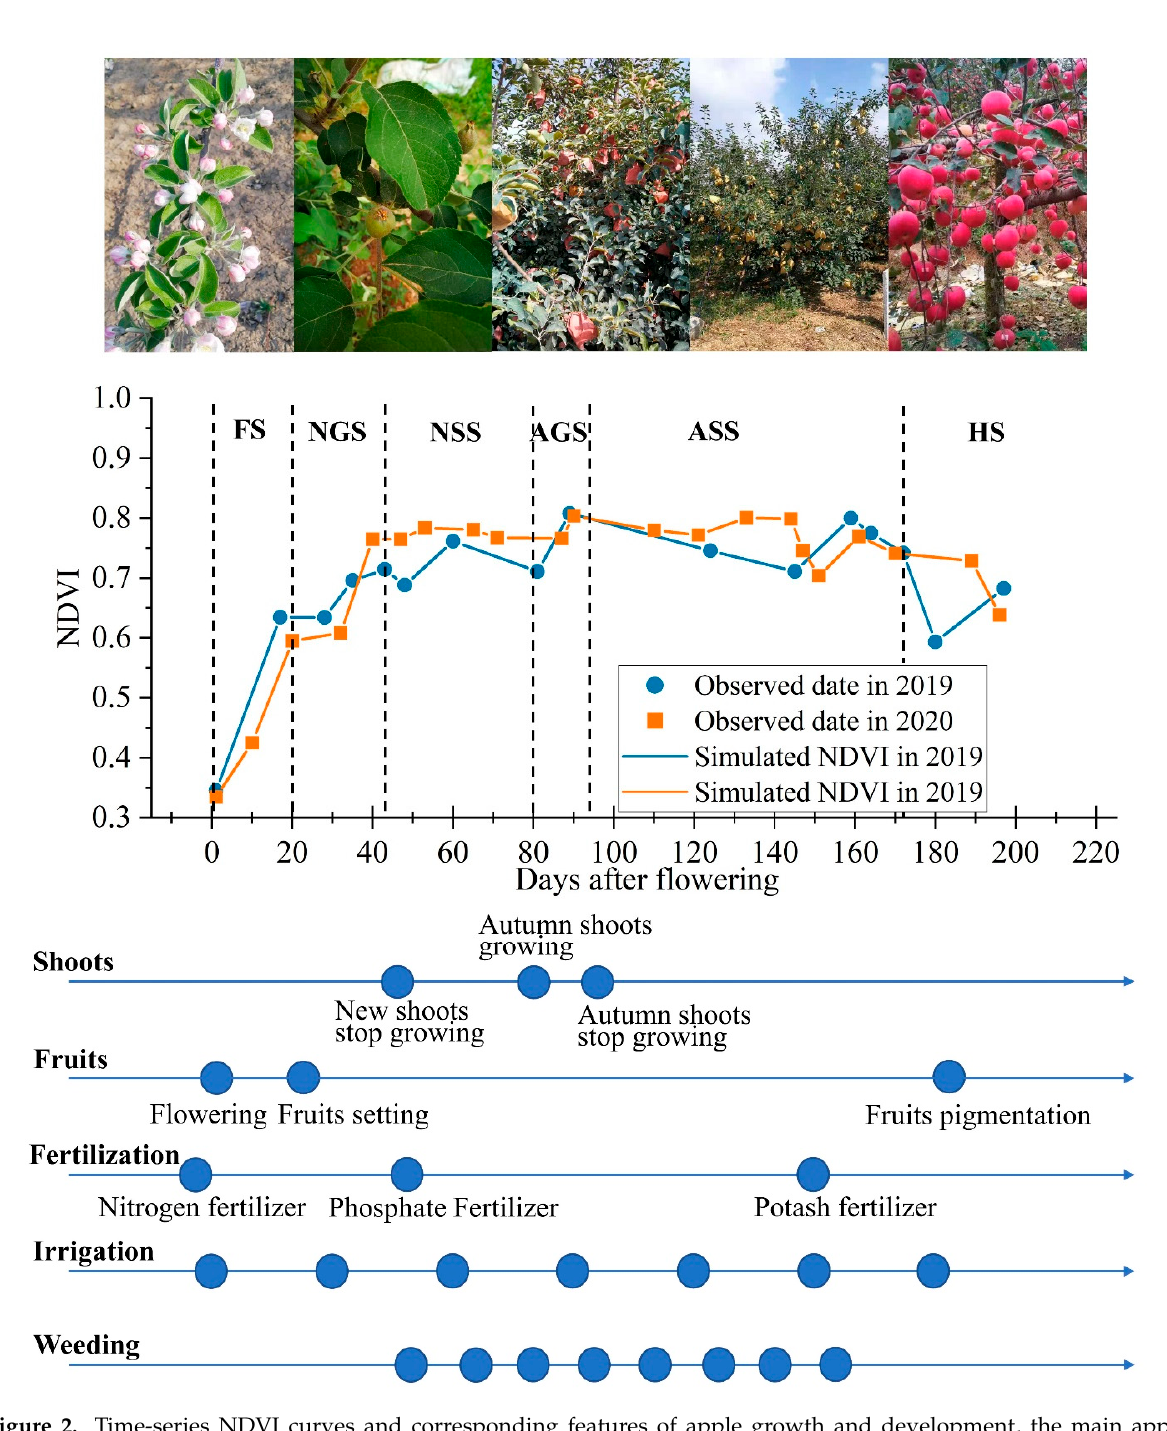
Figure 2. Time-series NDVI curves and corresponding features of apple growth and development, the main apple management measures. The blue dots represent the key features of apple growth and the main site practices. The FS, NGS, NSS, AGS, ASS, and HS represent the flowering stage, the new-shoot-growing stage, the new-shoot-stop-growing stage, the autumn shoot-growing stage, the autumn shoot-stop-growing stage, and the harvest stage, respectively.